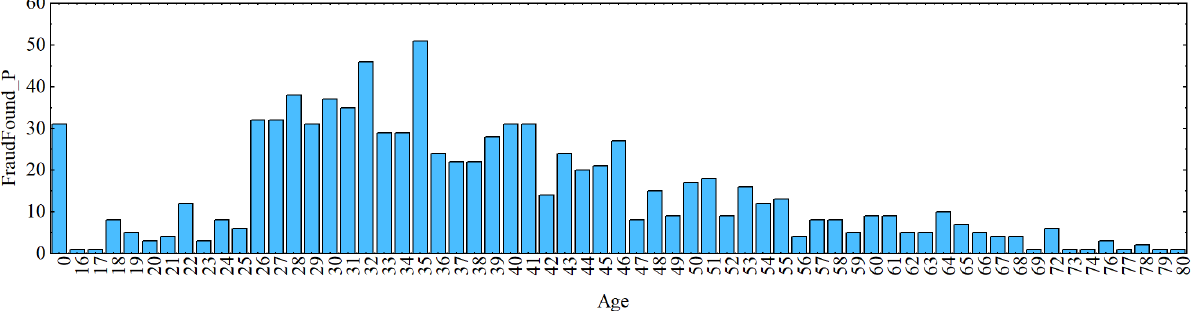
Figure 2. Association between Age and Fraud Found. The y axis “FraudFound_P” represents the number of rows for FraudFound_P =